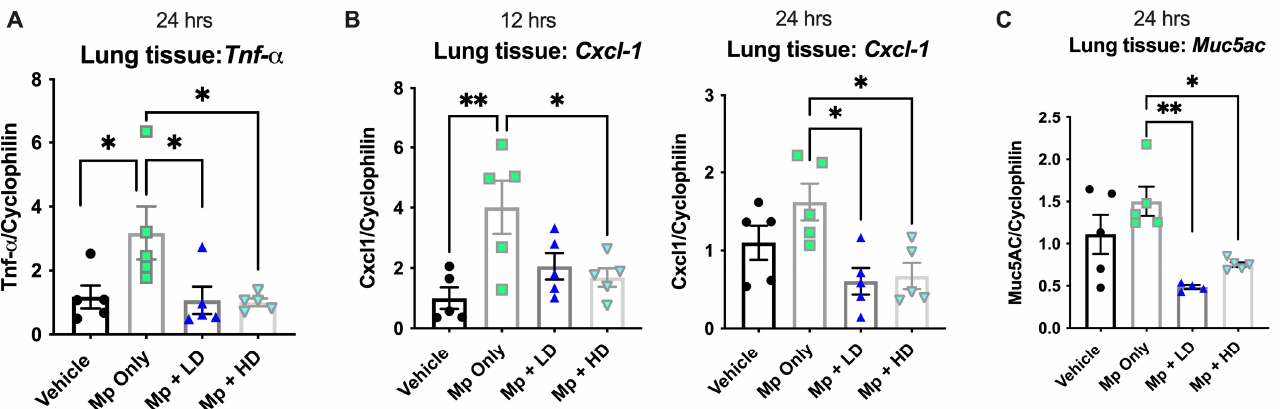
Figure 3. The effect of Ang-(1–7) on indices of inflammation during infection with Mycoplasma pneumoniae . ( A ) Tnf- α , ( B ) Cxcl1 (KC), and ( C ) Muc5AC gene expression were examined in lung tissue by RT-PCR in a subset of mice at either 12 h or 24 h post infection, as indicated. Data are expressed in mean ± SEM, relative to housekeeper gene expression. n = 5 mice/group and representative of two independent experiments. * p < 0.05, ** p < 0.01 by one-way ANOVA.